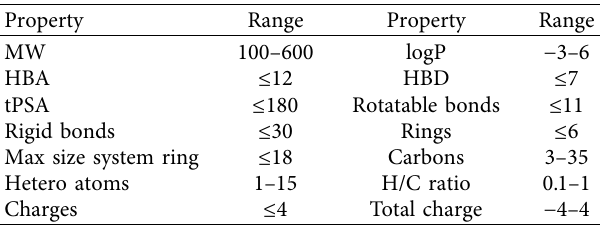
Table 1: Te range of the parameters of the “drug-like soft”